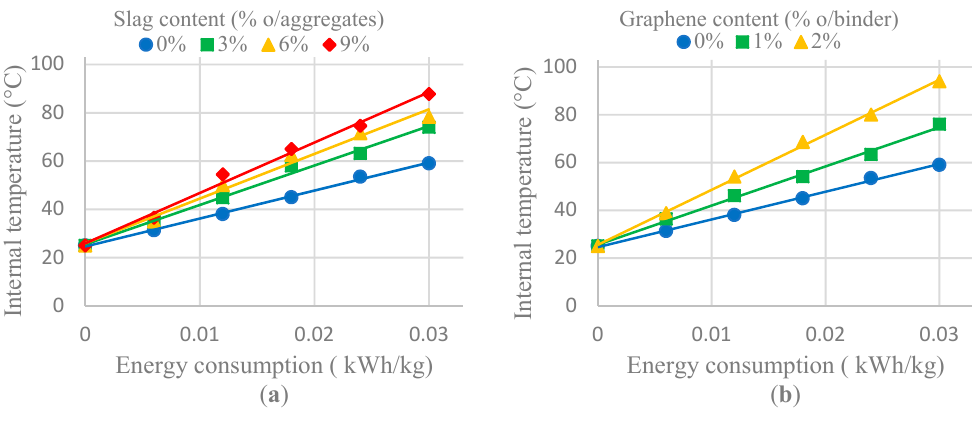
Figure 11. Effect of slag ( a ) and graphene ( b ) on the microwave heating consumption. Figure 11. E ff ect of slag ( a ) and graphene ( b ) on the microwave heating consumption. Table 3. Output of the linear regression Table 3. Output of the linear regression models.